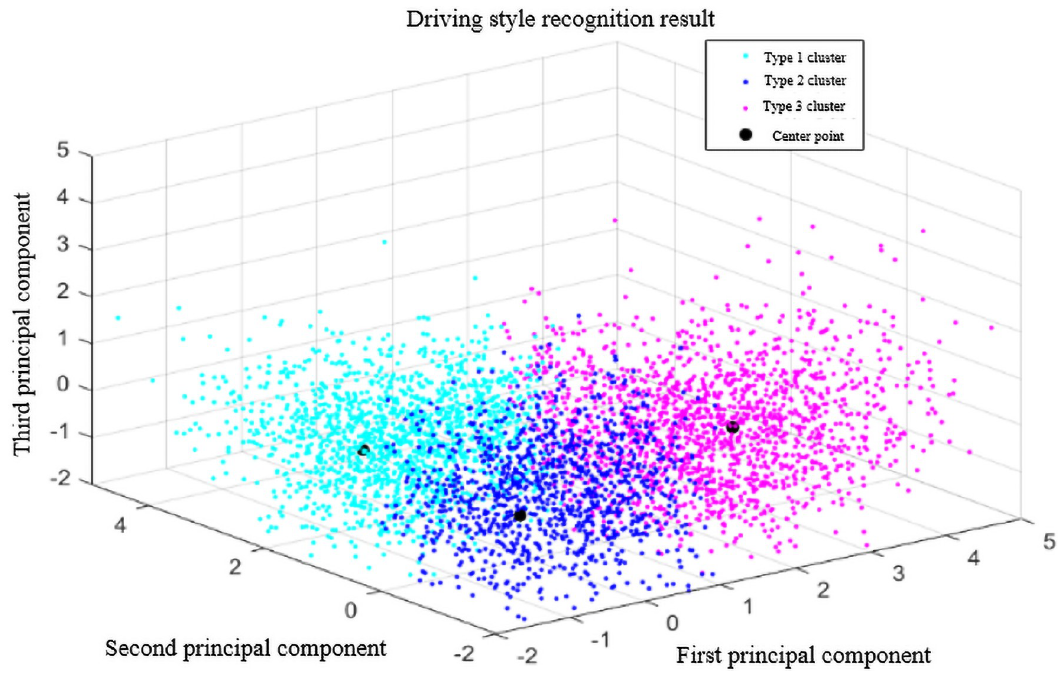
Fig 5. Driving style recognition